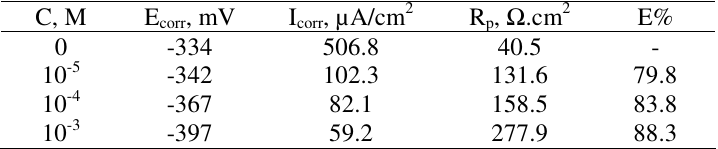
Figure 1. Polarization curves of steel at various concentrations of PNIP in 0.5 M HCl Table 2. Corrosion parameters of steel at various concentrations of PNIP and corresponding inhibition efficiencies